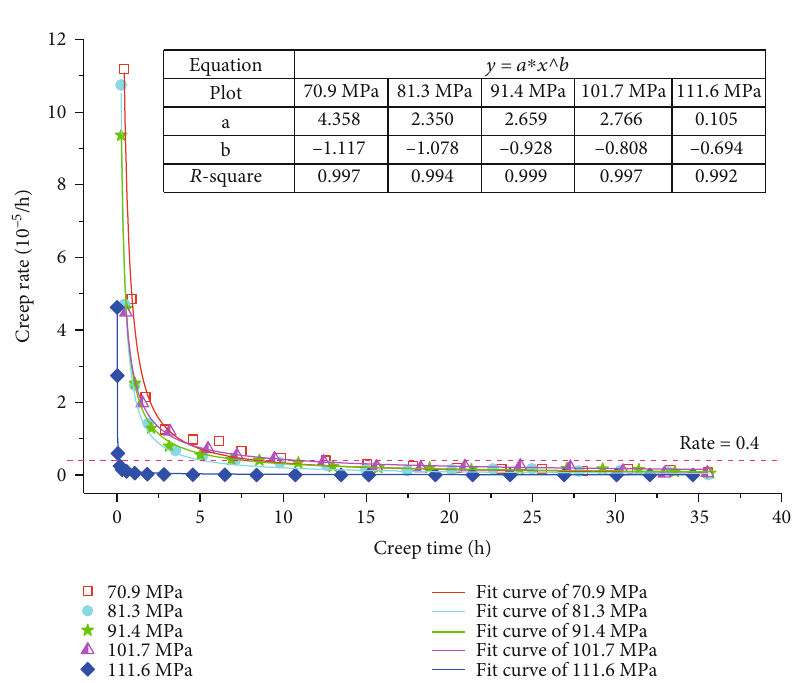
Figure 6: The evolution laws of the axial strain creep rate and time under deviatoric